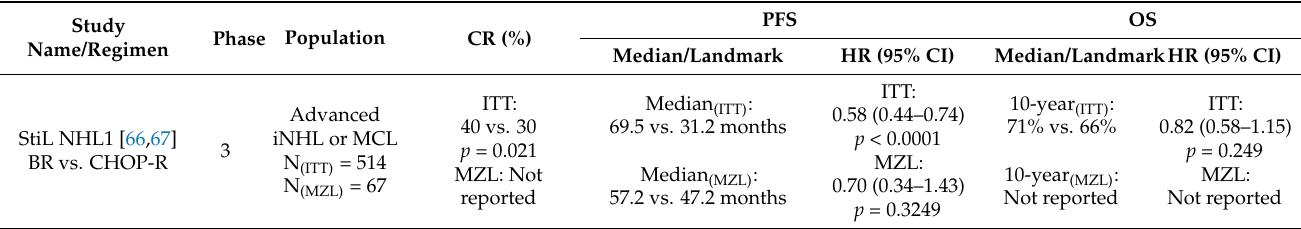
Table 1. Phase 2/3 prospective trials for first-line treatment of advanced/symptomatic MZL. Study Phase Name/Regimen